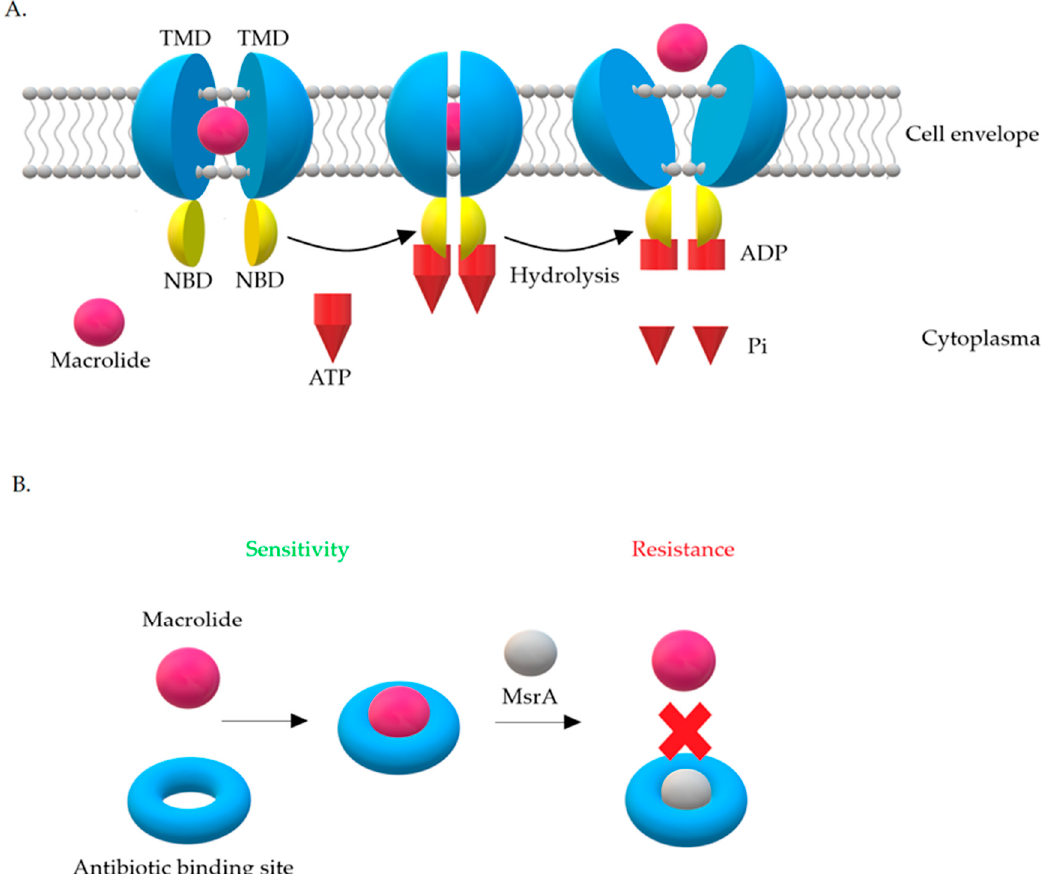
Figure 10. Mechanisms of resistance associated with the MsrA protein leading to resistance to 14- and 15-membered macrolides and streptogramin B (MS B phenotype): ( A ) Macrolide efflux from the bacterial cell [80], ( B ) MsrA acts as a protective protein.